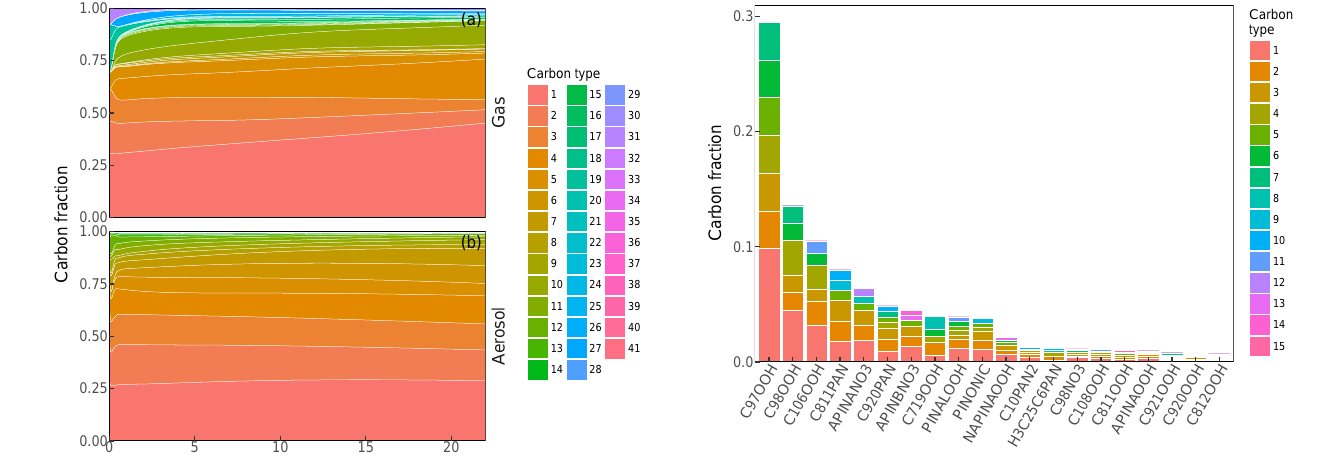
Figure 4. Compound and carbon type abundance for APIN simula- tion at t max SOA . C97OOH and C98OOH are large, polyfunctional compounds containing ketone and hydroperoxide groups. The car- bon types are defined in Fig. 2.